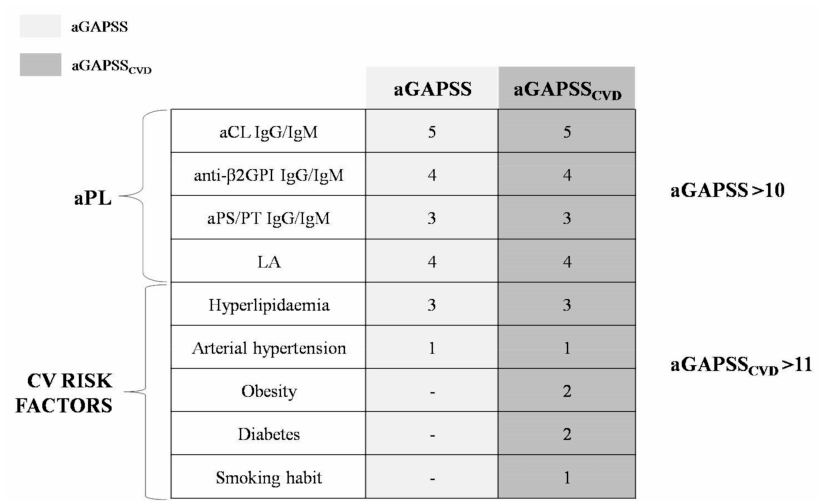
Figure 1. Adjusted Global AntiPhospholipid Syndrome Score (aGAPSS) and adjusted Global An- tiPhospholipid Syndrome Score for CardioVascular Disease (aGAPSS CVD ). aPL: antiphospholipid antibodies; CV: cardiovascular; Ig: immunoglobulin; aCL: anti-cardiolipin antibodies; anti- β 2GPI: anti- β 2-glycoprotein I antibodies; aPS/PT: anti-phosphatidylserine/prothrombin antibodies; LA: lupus anticoagulant; -: not applicable for